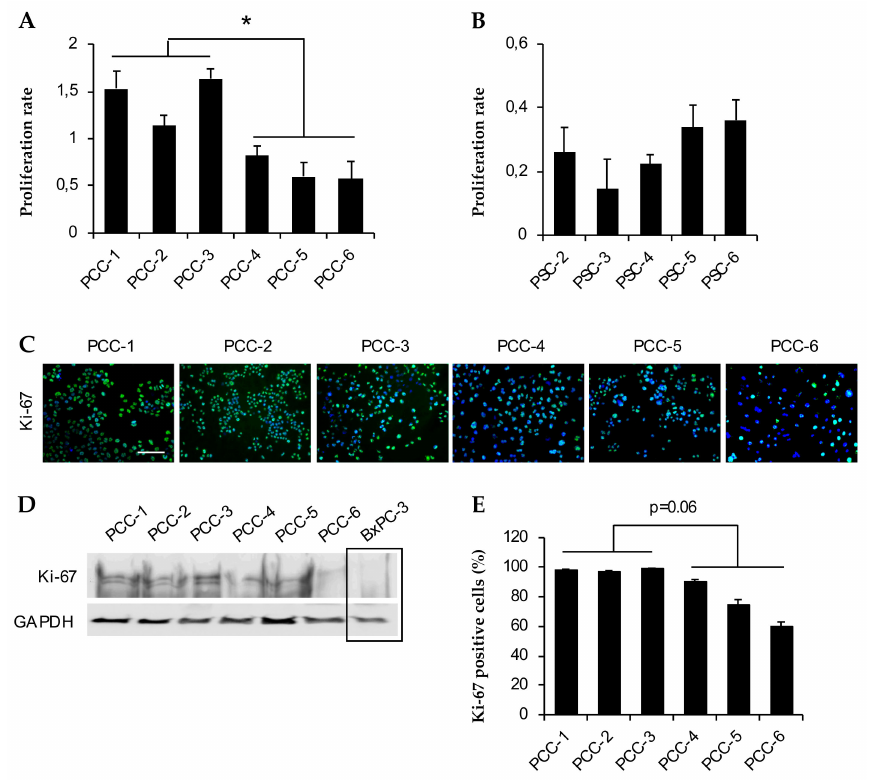
Figure 3. Assessment of proliferation: Cell proliferation rate obtained by measuring the percentage cell viability for PCCs ( A ) and PSCs ( B ) using 3-(4,5-Dimethylthiazol-2-yl)-2,5-Diphenyltetrazolium Bromide (MTT) assay at 24 and 72 h after cell seeding. * p < 0.05 comparing average proliferation rate for PCCs between treatment naïve (PCC-1, -2, and -3) vs neoadjuvantly treated (PCC-4, -5, and -6) group. ( C ) PCCs immunostained with antibodies against Ki-67 (green). Nuclei were stained with DAPI (blue). Scale bar = 100 µ m. ( D ) PCCs were lysed and proteins were subjected to immunoblotting using antibodies against Ki-67. GAPDH was used as a loading control. ( E ) Cells seeded in 96-well plates were immunostained with antibodies against Ki-67. Ten randomly selected fields (20 × magnification) from each well were counted to determine the percentage positive Ki-67 cells. Data are mean ± SEM of triplicate determinations. PCC, pancreatic cancer cell; PSC, pancreatic stellate